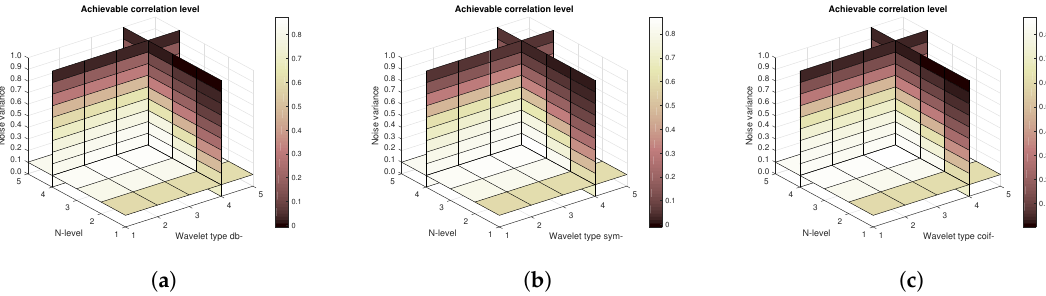
Figure 18. Achievable correlation levels in the presence of Salt and Pepper noise only for the CT scan from Figure 4 with use of three mother wavelet families—from left Daubechies ( a ), Symlet ( b ) and Coiflet ( c ).